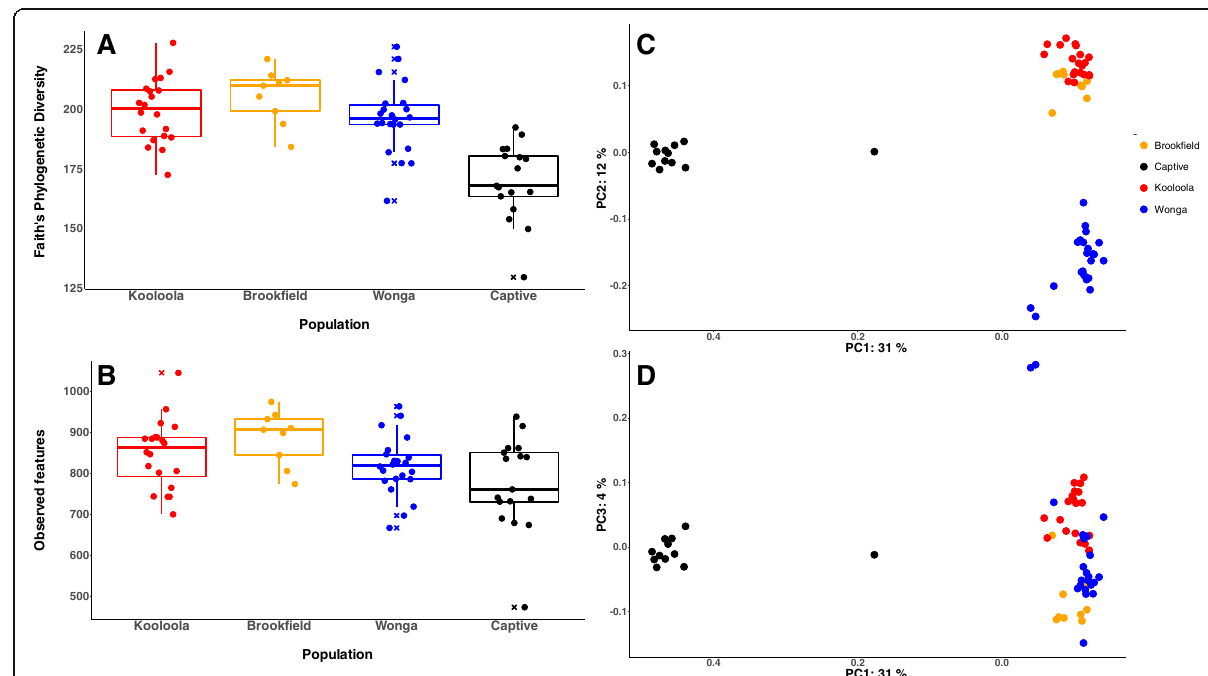
Fig. 2 Microbial diversity and composition of SHNW faecal samples from different populations: Kooloola and Brookfield (degraded habitat), Wonga (intact habitat), and captive. a Captive individuals had significantly lower phylogenetic diversity of microbes compared to wild individuals, and b significantly lower microbial richness (except vs. Wonga). Horizontal lines in the boxes represent the median values; the lower and upper bound of boxes represent 25th and 75th percentiles, respectively. Outliers are marked with a cross. c/d Principal coordinates analysis (PCOA) of unweighted UniFrac distances show clear separation of microbial compositions between captive and wild individuals across PC1. c shows PC1 vs PC2 and d shows PC1 vs. PC3. Each point represents a SHNW faecal sample, coloured by population, and the distances between points represents microbial composition differences (i.e. points closer together have more similar microbial